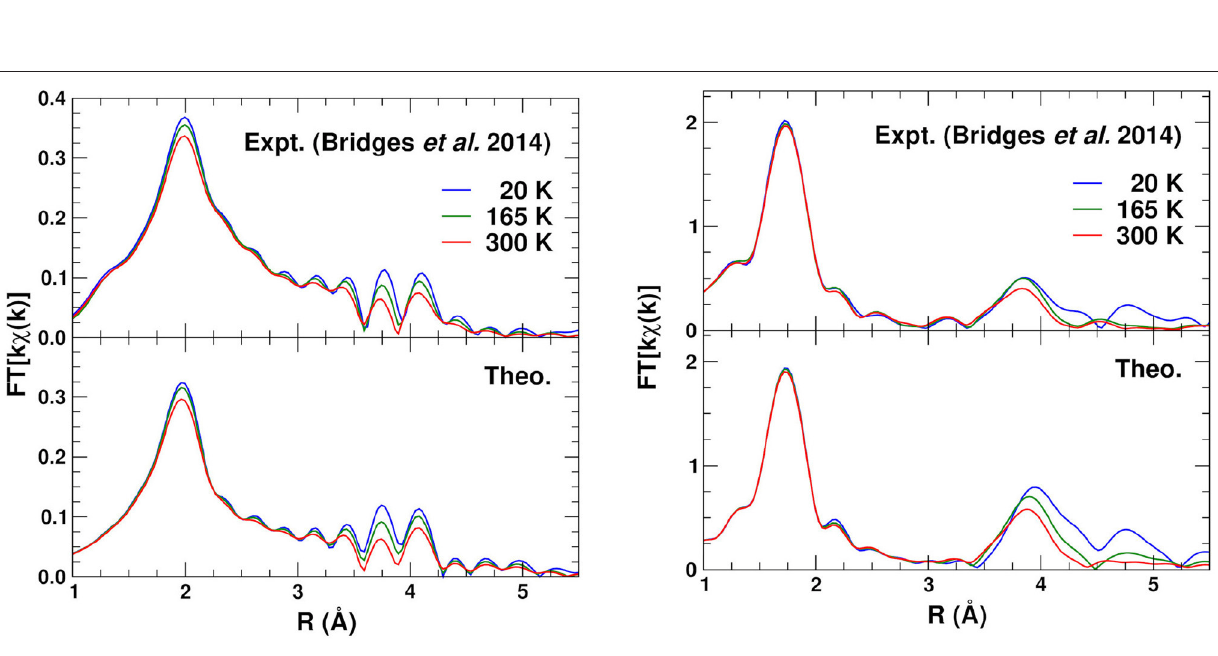
FIGURE 8 | Comparison of the Fourier transforms of the experimental (Bridges et al., 2014) and theoretical k χ ( k ) ( Figure 7 ) at 20, 165, and 300 K for the Zr K edge (left) and the W L 3 edge